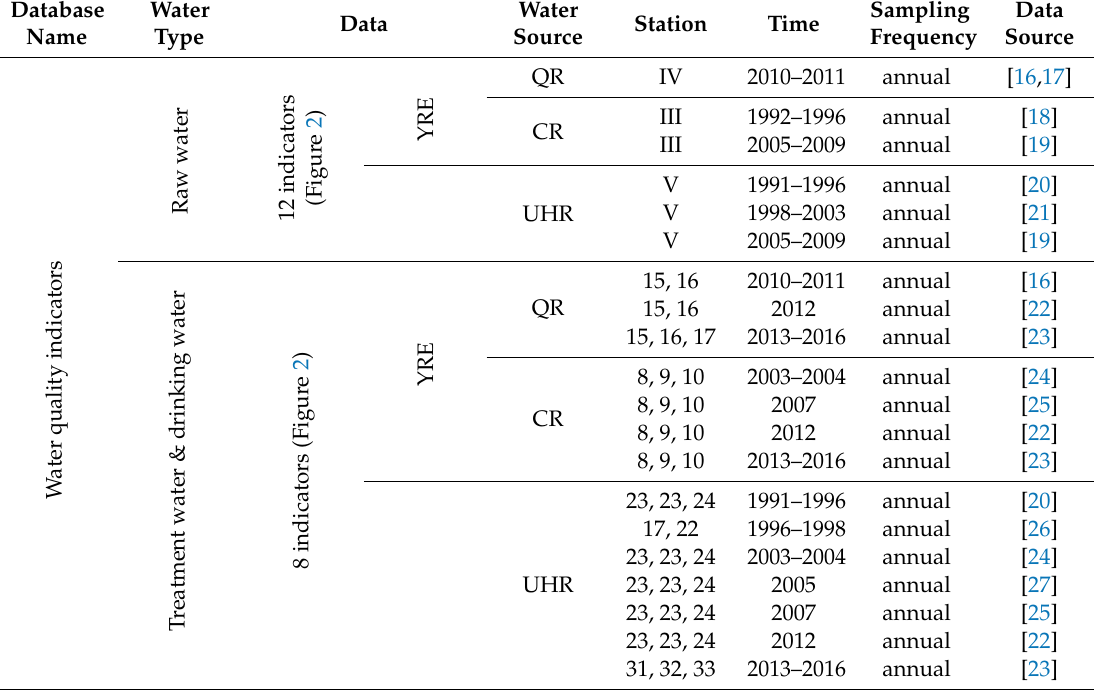
Table 1. Data sources for water quality contaminants and threat factors for raw water, treated water and drinking water in Shanghai. Where the sampling frequency is given as ‘annual’ this is the mean of samples collected over the